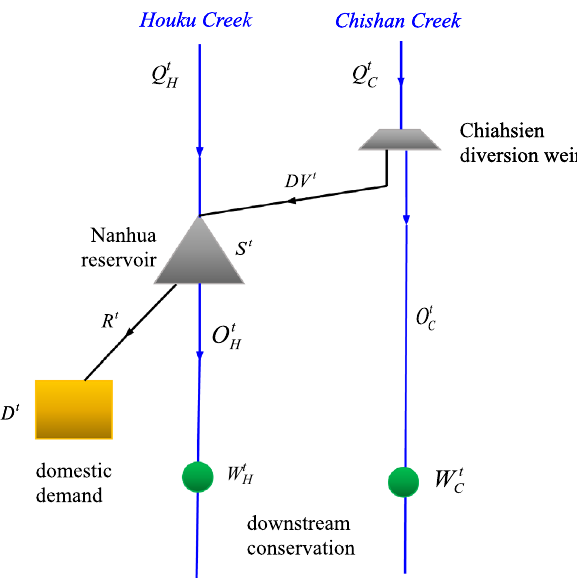
Fig. 1 Schematic operation system of the Nanhua Reservoir and the Chiahsien diversion